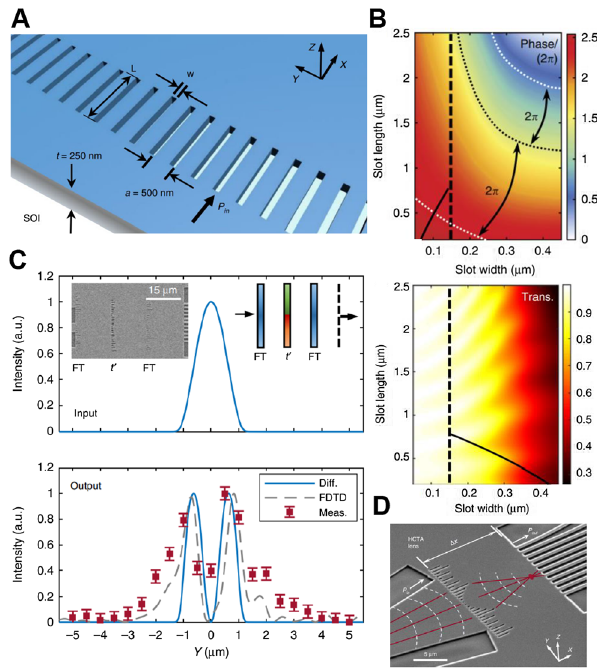
Figure 7: On-chip analog computing based on a Si-on-insulator (SOI) platform [40]. (A) Schematic representation of an on-chip high-contrast transmitarray defined on a SOI substrate to manipulate the transmittance and phase response of the in-plane propagating wave.(B)Simulatedamplitude(toppanel)andphase(bottompanel) spectraof thetransmittedfieldas functionsofthe slotwidth( w ) and height ( h ) for an incident wavelength of 1550 nm. Contours with 2 π phase shift are depicted by dotted lines. (C) The input incident wave pro fi le (top panel) and analytical, simulated, and measured distribution at the output (bottom panel) of the on-chip differentiator. The conceptual design and scanning electron microscopy(SEM)ofthefabricateddeviceareshownintheinset.(D) SEM of the fabricated on-chip metalens located in front of a mode expander and coupled to 11 single-mode waveguides to facilitate characterization of the spatial distribution of focused